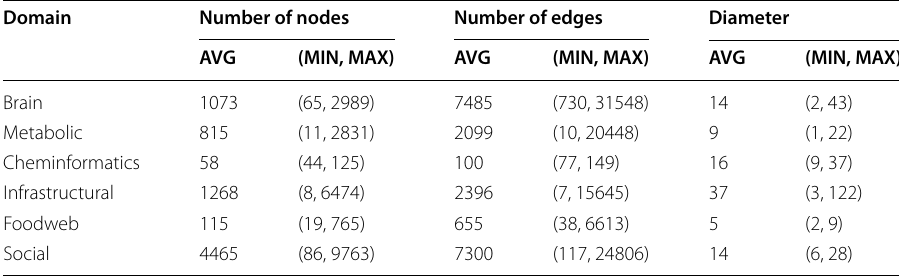
Table 4 Some of the main features of the collected real networks. The average, minimum, and maximum values of the number of nodes, the number of edges, and the diameter of the networks by